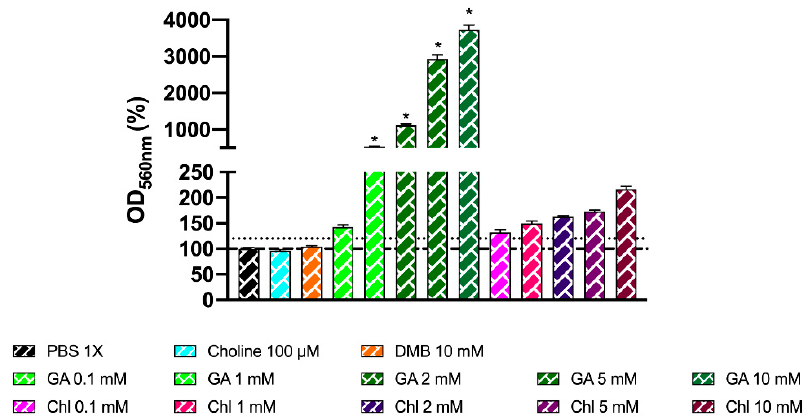
Figure 12. Effect of choline 100 µM, DMB 10 mM, gallic acid (0.1–10 mM), and chlorogenic acid (0.1–10 mM) on MTT reagent reduction to colored product. Reactions occurred in anaerobic conditions (O 2 < 15 ppm) for 30 min with PBS 1X (filter-sterilized and N 2 -sparged) as diluent, without fermentation media or fecal slurry. Results are expressed as mean % compared to the vehicle conditions) ± SEM ( n = 6). * p < 0.0001 by one-way ANOVA (Dunnett’s post hoc test versus PBS 1X). Abbreviations: DMB, 3,3-dimethyl-1-butanol; GA, gallic acid; and Chl, chlorogenic acid. Dotted discontinuous line marks 120% in OD 560 nm (%).